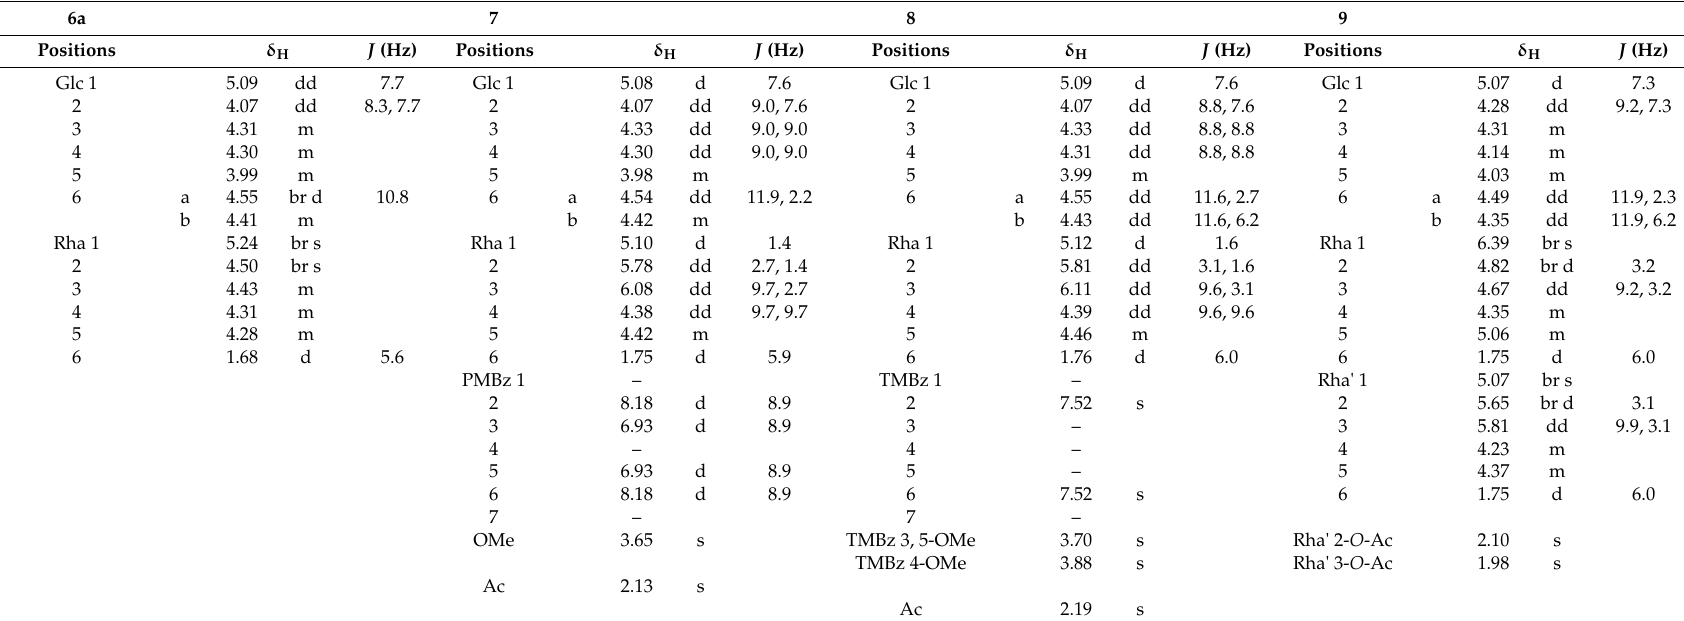
Table 2. 1 H-NMR spectral data for the sugar and acyl Moieties of 6a and 7 – 12 in C 5 D 5 N.